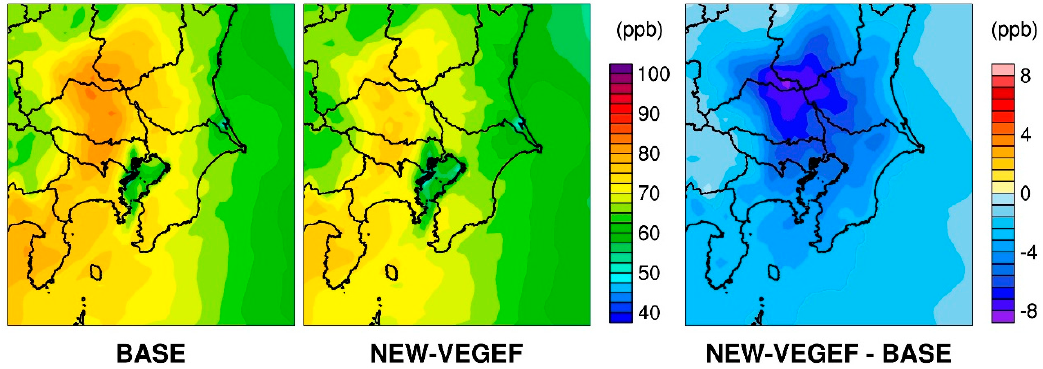
Figure 7. Horizontal distributions of mean surface MDA8O3 simulated in the BASE and NEW-VEGEF cases during the target period in d04. Differences between the two cases are also shown.